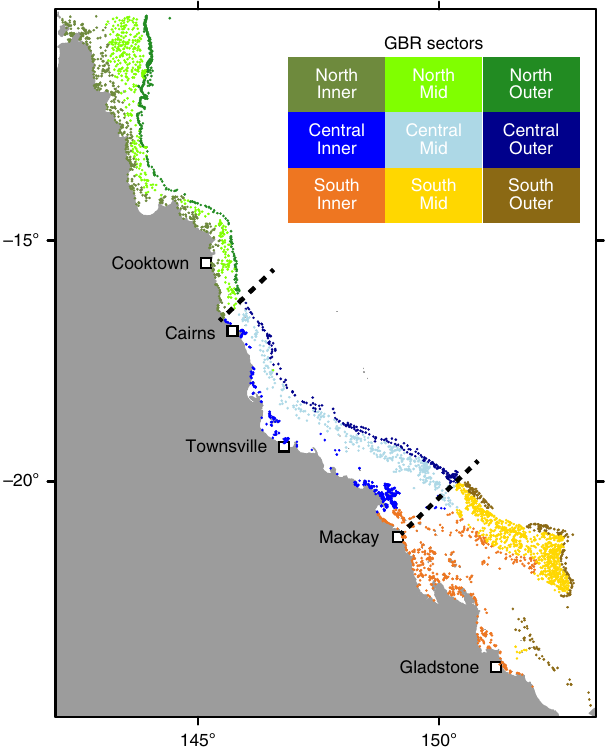
Fig. 1 Dividing the Great Barrier Reef into geographical sectors. The colours of reef centroids show the division of reefs into northern, central and southern as well as inner-, mid-, and outer-shelf sectors. Thresholds used to simulate staggered latitudinal spawning events are shown as black dashed